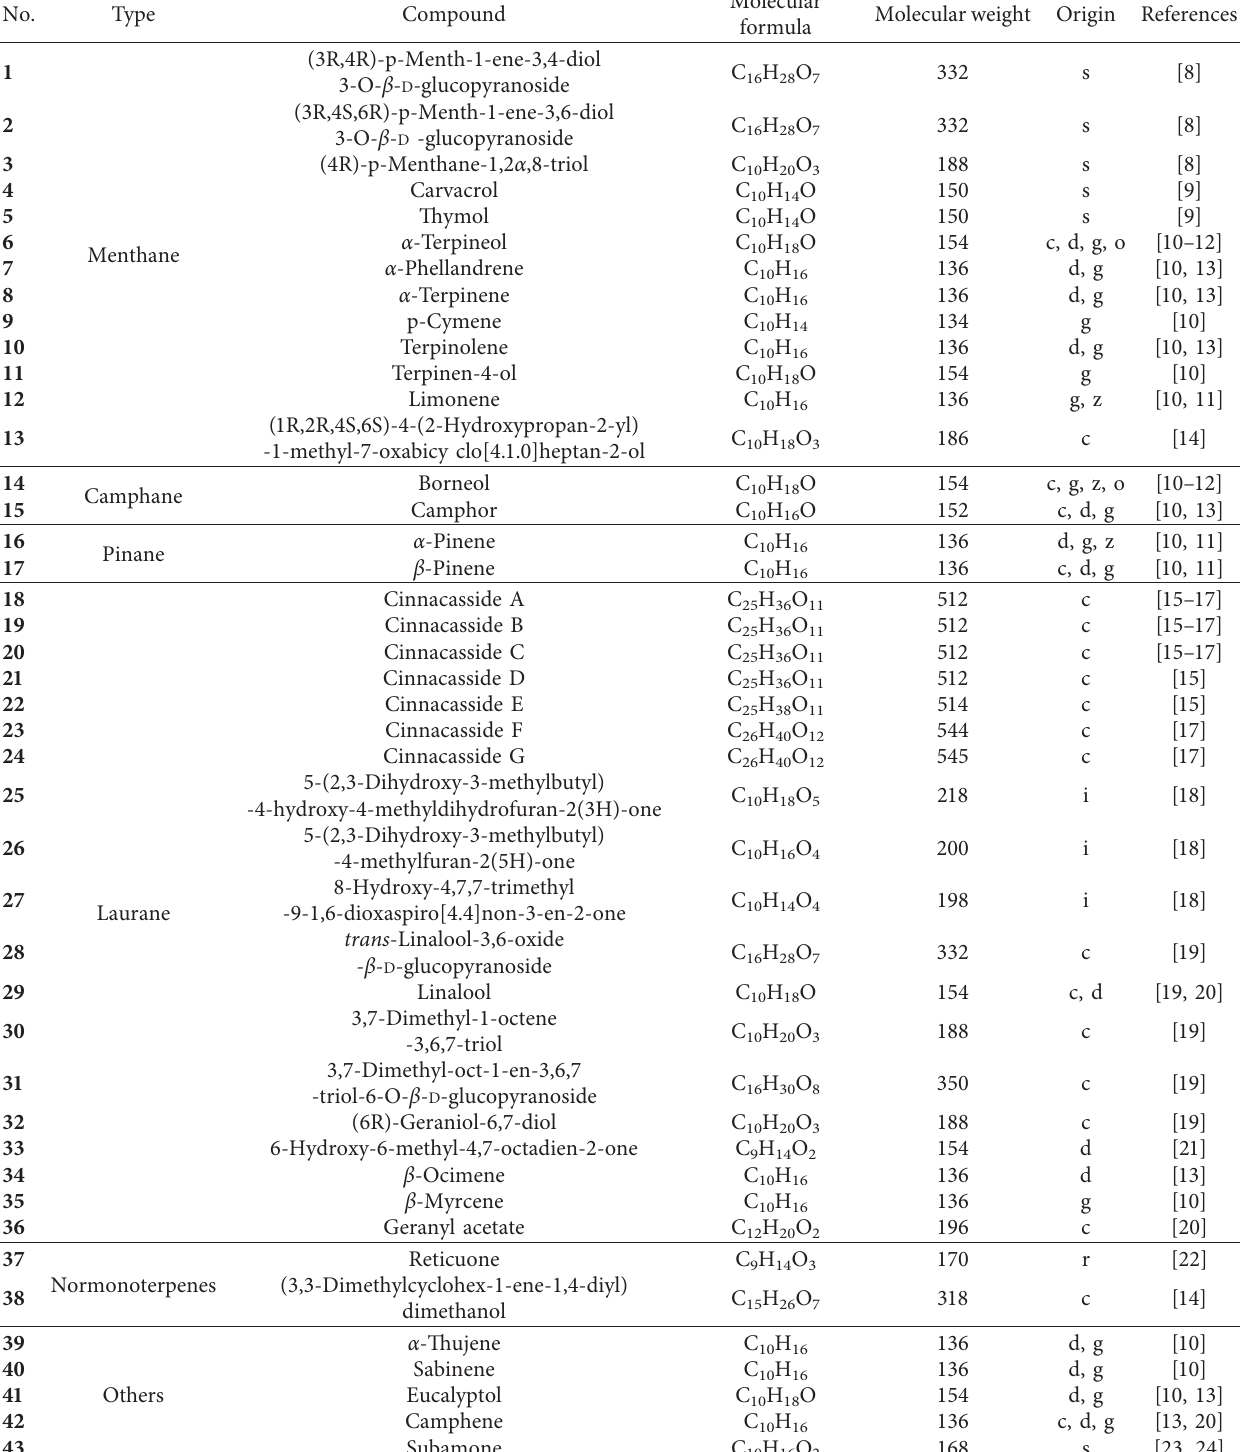
Table 1: Monoterpenes from the genus Cinnamomum .